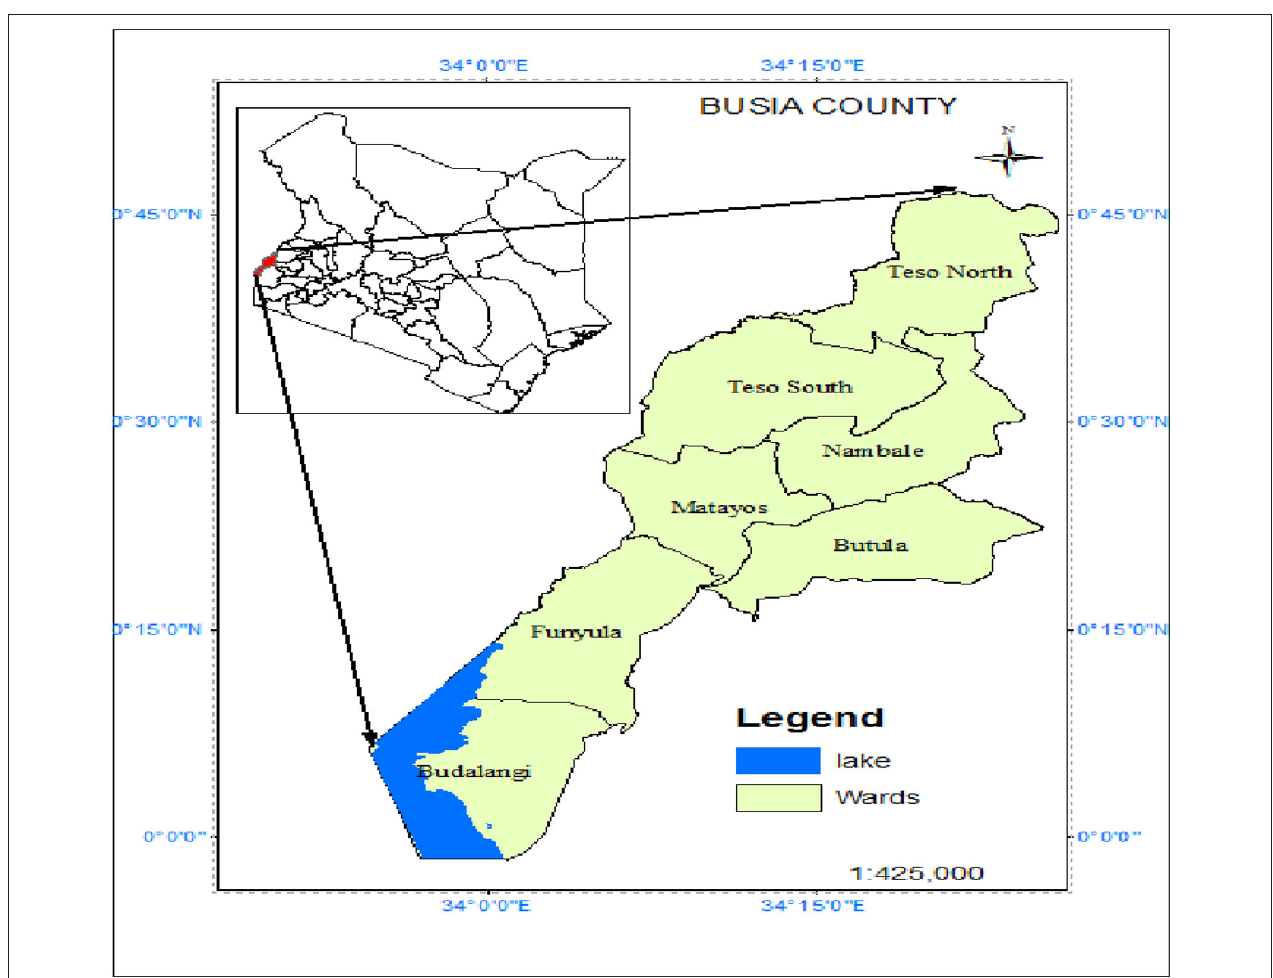
FIGURE 3 | Map showing Busia County with associated